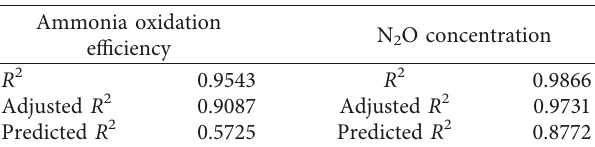
Figure 4: Response surface plot and contour plot showing the effect of independent variables X Table 7: The comparison between adjustment coefficients for two response surfaces.